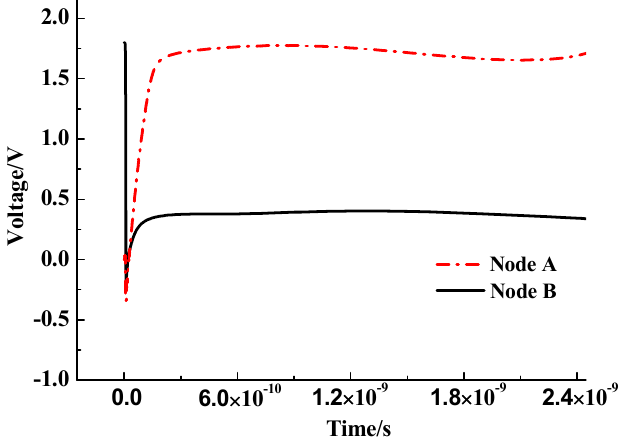
0.0 Figure 5. The storage node potentials as a function of time for SEE. Figure 5. The storage node potentials as a function of time for SEE. Figure 5. The storage node potentials as a function of time for in the PSS direction is shown in Figure 6. The storage node potential evolution versus time is plotted in Figure 7. The potential distributions of the SRAM cell are the same as those induced by SEE before and after the event as a result of the same configuration.